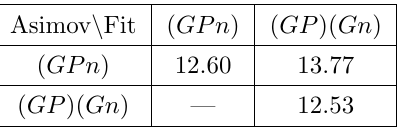
Table 1 . (cid:1) (cid:31) 2 computed with and without the approximation ( GP )( Gn